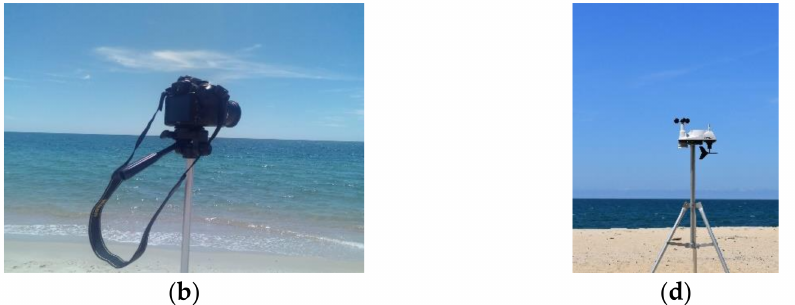
Figure 1. ( a ) Offshore optical sensor setup; ( b ) onshore optical sensor setup; ( c ) offshore weather station setup; ( d ) onshore optical sensor setup.